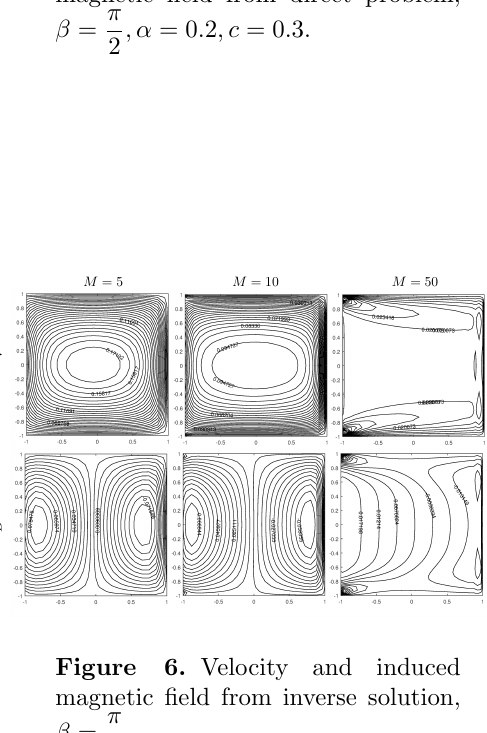
Figure 3. Velocity and induced magnetic field from direct problem,